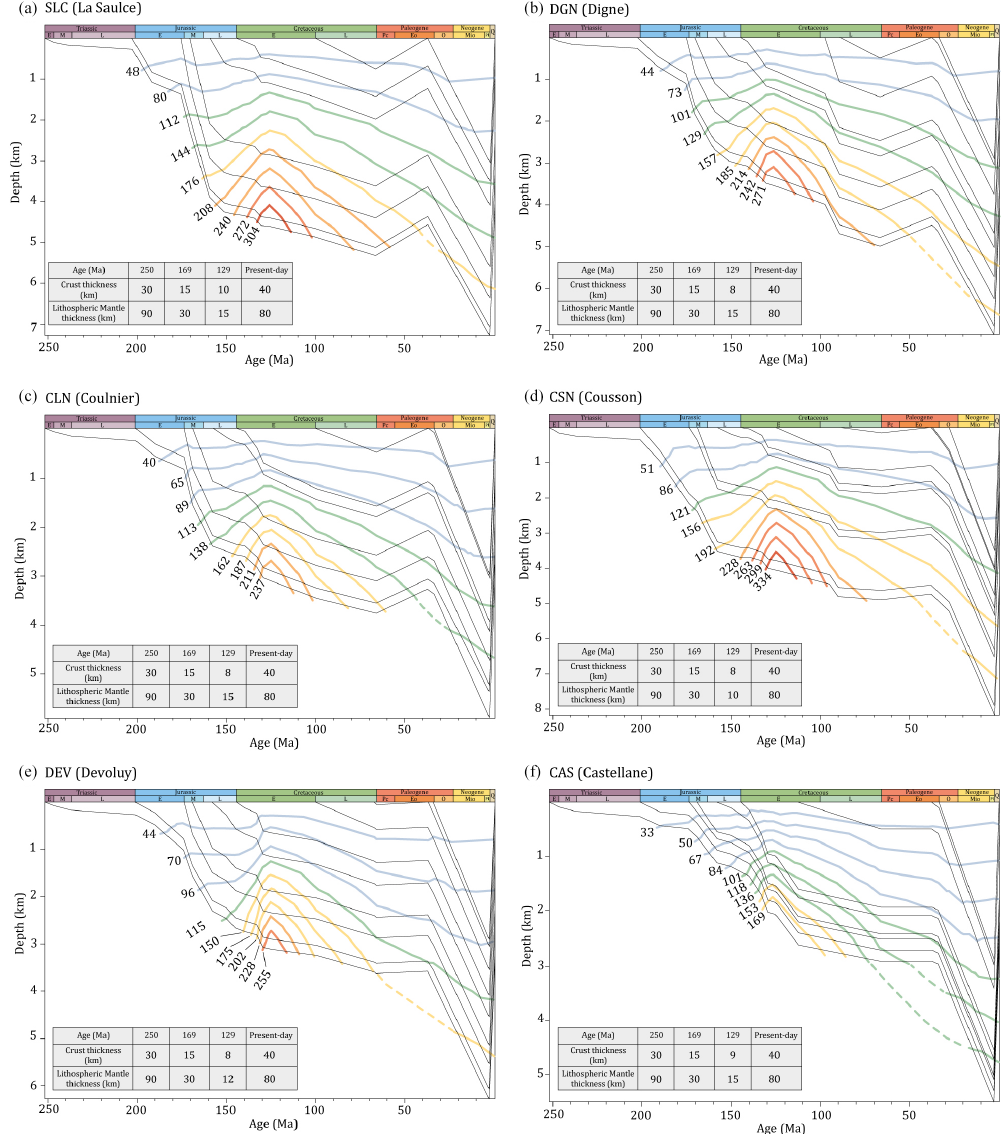
Figure 5. Burial histories from decompacted stratigraphic columns generated with TemisFlow ® for the Two-rifts model. See location of stratigraphic sections in Fig. 1 and their detailed stratigraphy in Fig.